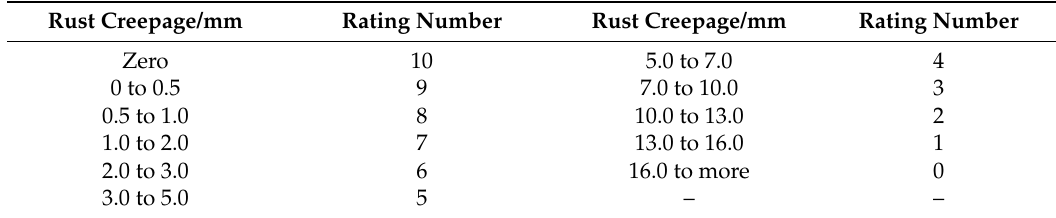
Table 3. Rating number of failures at